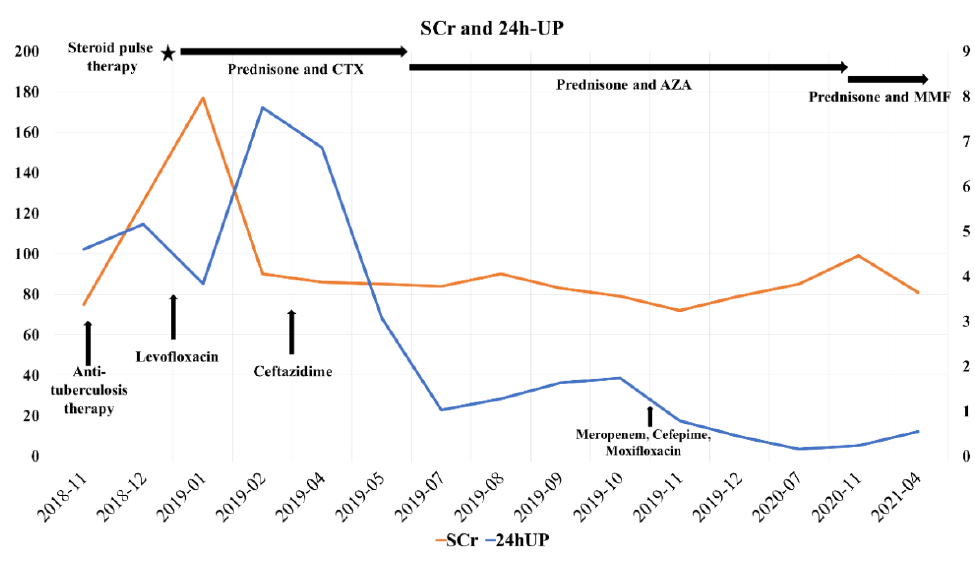
Figure 3. Changes in serum creatinine (orange line, µmol/L, left axis), 24 h urine protein (blue line, g/24 h, right axis) and the treatment of the patient. Immunosuppressive therapy: In January 2019, the patient received steroid pulse therapy (methylprednisolone 1 g every day for 3 days). From January to June 2019, the patient was treated with prednisone (60 mg/d for 7 weeks, subsequently reduced by 5 mg every two weeks to 10 mg/d maintenance) and cyclophosphamide (0.2 g every other day, cumulative dose 16 g) orally. From July 2019 to December 2020, the patient received oral prednisone (10 mg/d) and azathioprine (50 mg/d for 6 months, subsequently 75 mg/d for 1 year). From January to March 2021, the patient received oral prednisone (30 mg/d for 1 month, 50 mg/d for 1 month, subsequently reduced by 5 mg every week) and mycophenolate mofetil (1.5 g/d for 2 months). Antibiotic therapy: From October (Figure 2A) to December 2018 (Figure 2B), the patient received anti-tuberculosis treatment (isoniazid 0.5 g/d, pyrazinamide 0.75 g/d and ethambutol 1.5 g/d). In January, April (Figure 2D) and November (Figure 2F,G) 2019, the patient received short-term antibacterial treatment three times. means steroid pulse therapy.